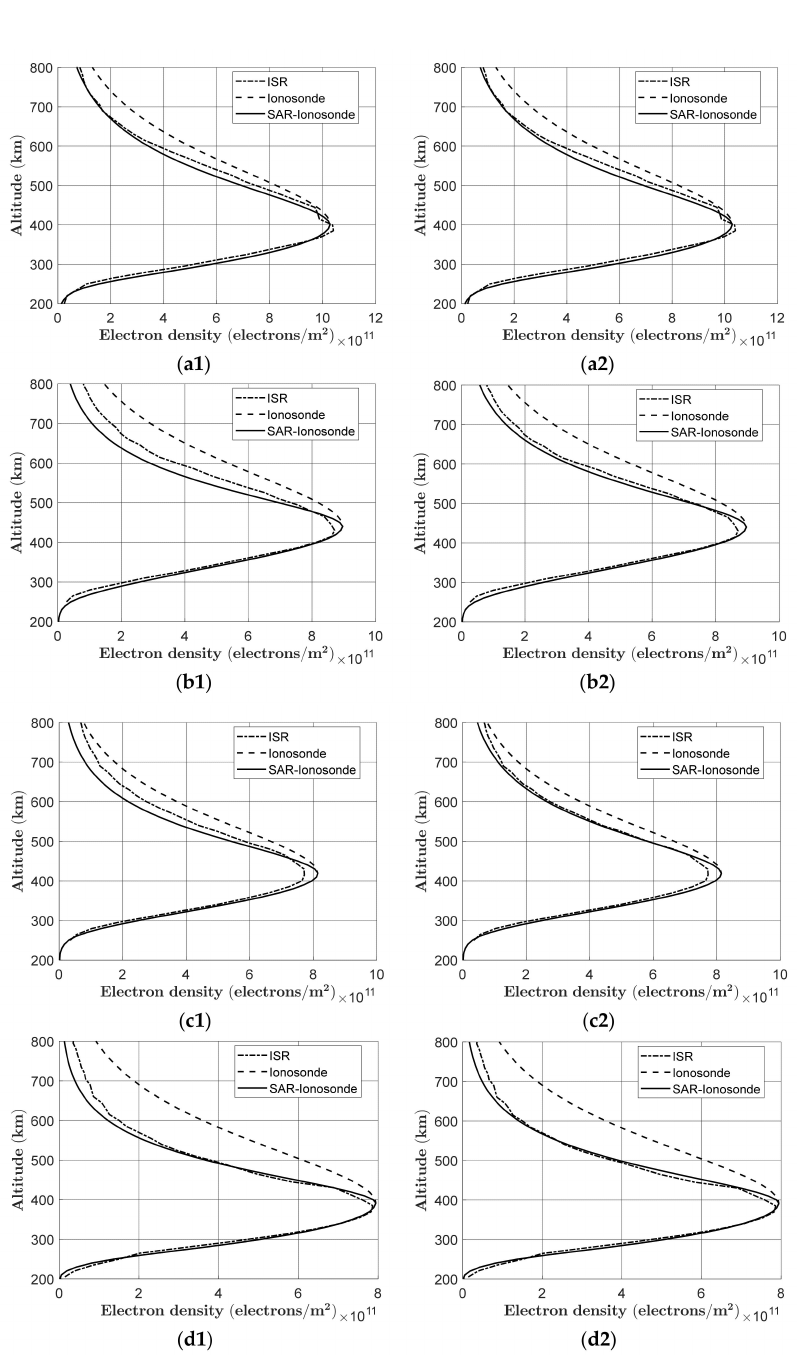
Figure 9. Combined retrieval of electron density using four groups of L-band and P-band SAR and the ionosonde with low systematic errors. Figures ( a1 – d1 ) in the left column are results of L-band from 23:00 to 02:00 12 June 2002. Figures ( a2 – d2 ) in the right column are results of P-band from 23:00 to 02:00 12 June